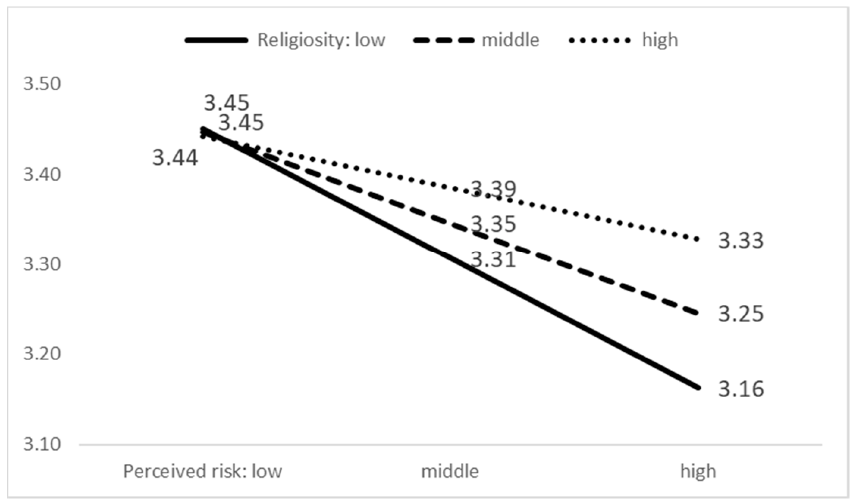
Figure 4. Perceived risk (IV) × religiosity (M) = skepticism (DV). Note: IV (independent variable), M (moderator), DV (dependent variable).